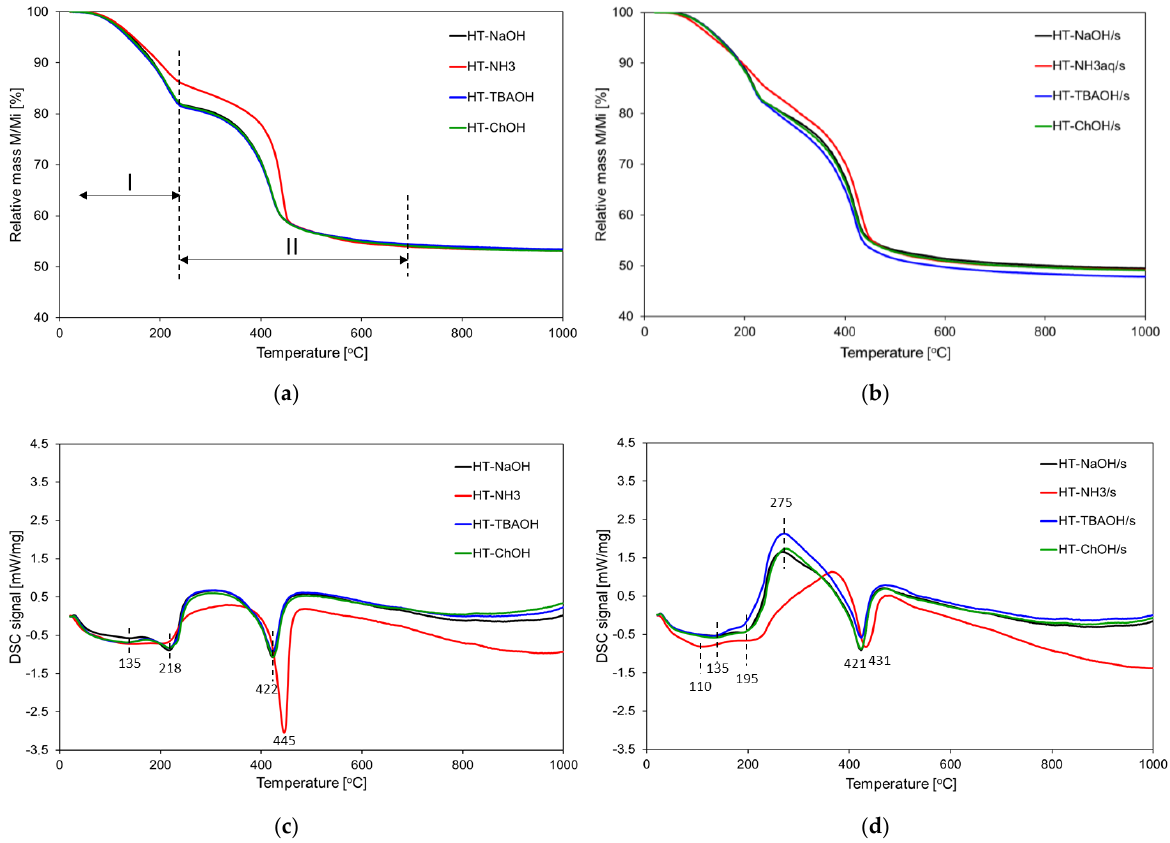
Figure 5. Thermal analysis of HT materials obtained with the use of different precipitating bases: ( a ) TG of samples synthesized in water; ( b ) TG of samples synthesized in aqueous starch solution; ( c ) DSC of samples synthesized in water; ( d ) DSC of samples synthesized in aqueous starch solution.